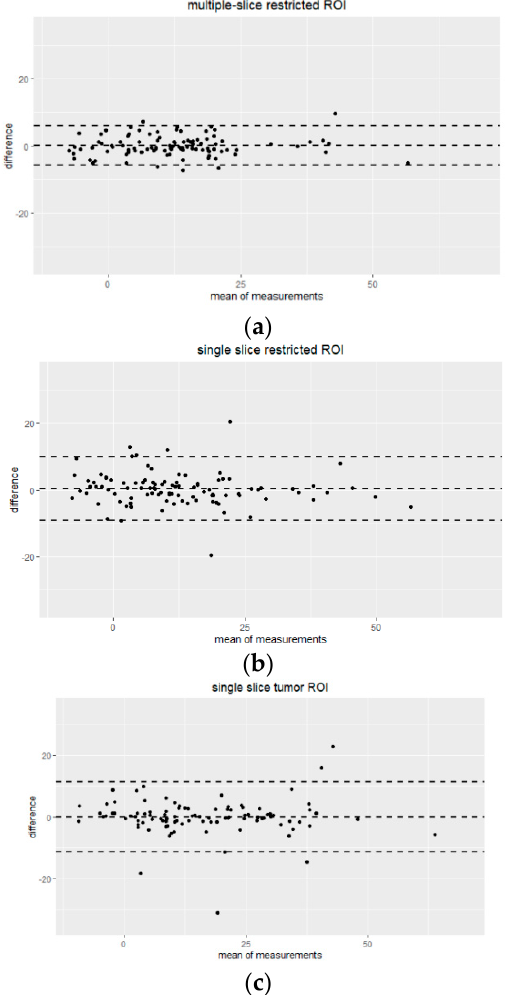
Figure 4. Bland-Altman plots showing the agreement of percentage change in mean tumor ADC measurements by Reader 1 and Reader 2 for three different ROI approaches: ( a ) multiple-slice restricted ROI, ( b ) single-slice restricted ROI and ( c ) single-slice tumor ROI. The x-axis shows the mean of measurements (percentage change in mean tumor ADC), and the y-axis shows the difference between measurements from two readers. The unit for both axes are %. The mean difference across all measurements is represented by the horizontal dotted line in the middle and 95% limits of agreement (mean ± 1.96 SD) are shown as horizontal dotted lines above and below the